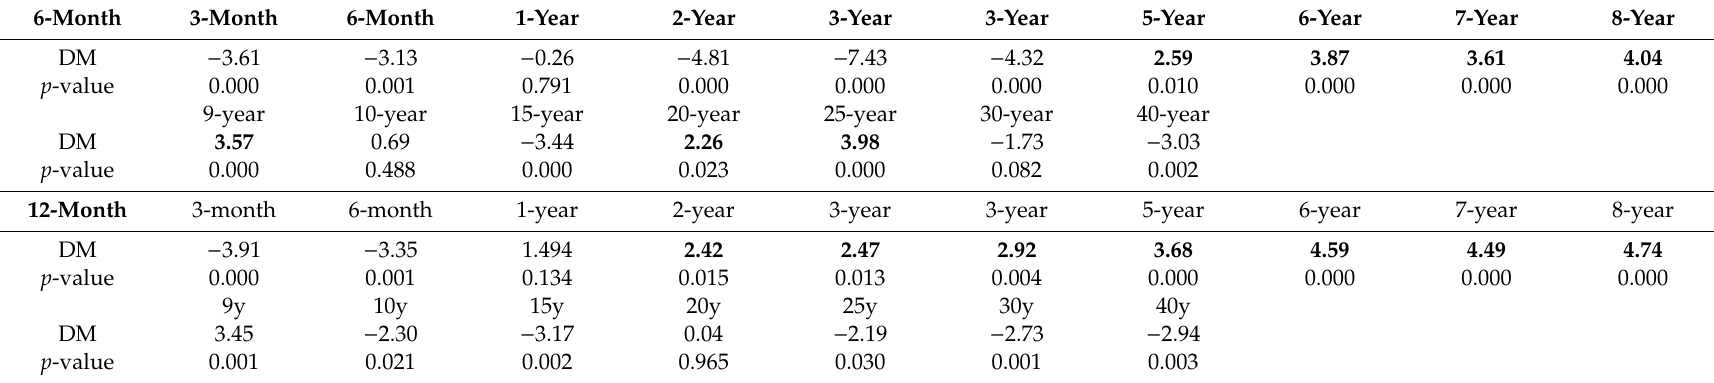
Table 8. Diebold–Mariano test for 6- and 12-month forecasting of each maturity of the zero-yield government bond (random walk model and DNSS (Ind)